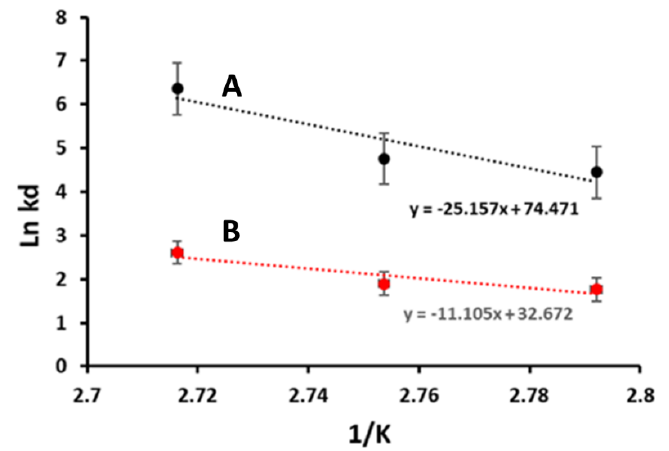
Figure 6. Arrhenius plots to calculate activation energy “Ed” for irreversible thermal inactiva- tion/denaturation of free and immobilized Man/Cel5B. ( A ) Free Man/Cel5B. ( B ) Immobilized Man/Cel5B.